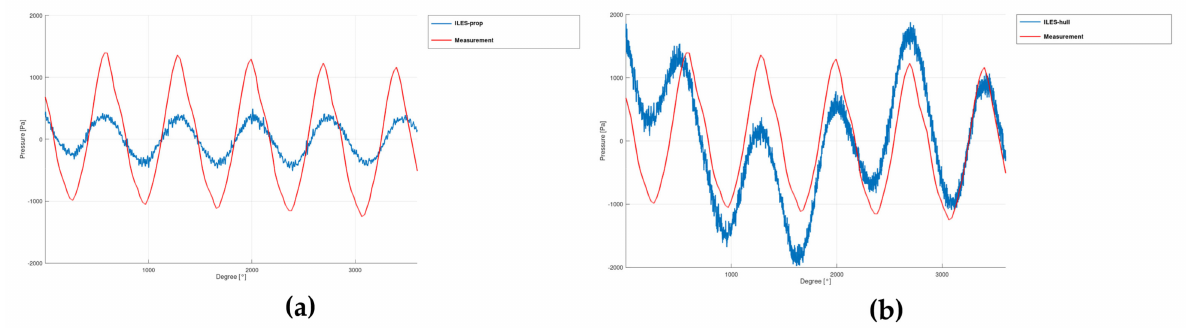
Figure 11. ProNoVi target case. Comparison of ILES time signal excerpts: ( a ) propeller only; ( b ) propeller and hull.